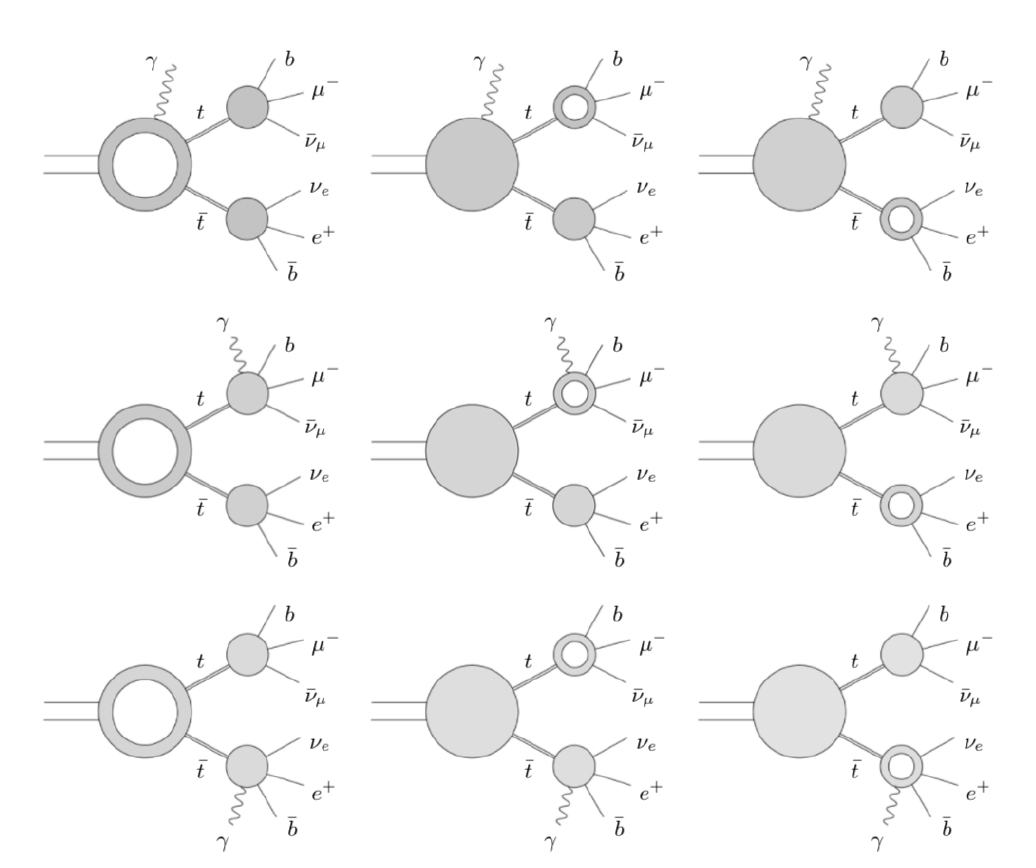
Figure 2 . Schematic representation of one-loop contributions for the t (cid:22) t(cid:13) production process in the NWA. For simplicity only top quarks are treated in NWA. The three rows show the three contributions from eq. (2.7). The full blobs represent tree-level sub-amplitudes whereas the blobs with a hole denote sub-amplitudes with one-loop corrections